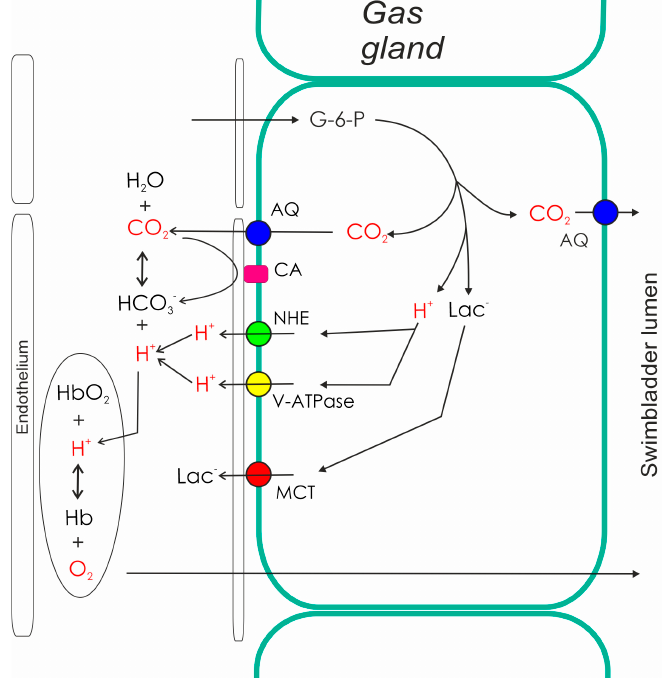
Figure 2. Secretory activity of gas gland cells. The metabolism of gas gland cells of the European eel depends on blood glucose, which is converted to lactic acid (lactate anion and a proton), and used for the production of CO 2 . CO 2 production in the pentose phosphate shunt by far exceeds the amount of CO 2 produced in the aerobic metabolism. Protons, CO 2 , and lactate are released into the blood, where the acidification switches on the Root effect. The resulting increase in PO 2 provides the partial pressure gradient for the diffusion of oxygen into the swimbladder. The production of CO 2 in gas gland cells also generates a partial pressure gradient towards the swimbladder lumen, allowing for the secretion of CO 2 into the swimbladder. AQ, aquaporin; CA, carbonic anhydrase; G- 6-P, glucose-6-phosphate; Hb, hemoglobin; Lac, lactate; NHE, sodium proton exchanger; MCT, monocarboxylate carrier.